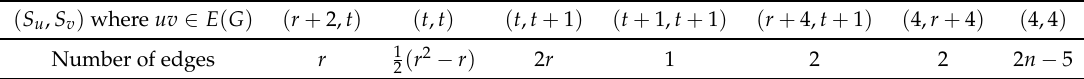
Table 10. The edge partition of the graph G for k = 1.